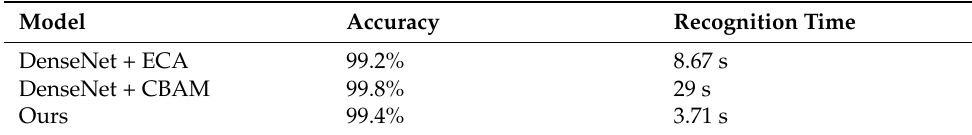
Table 7. Comparison with other attention mechanisms.